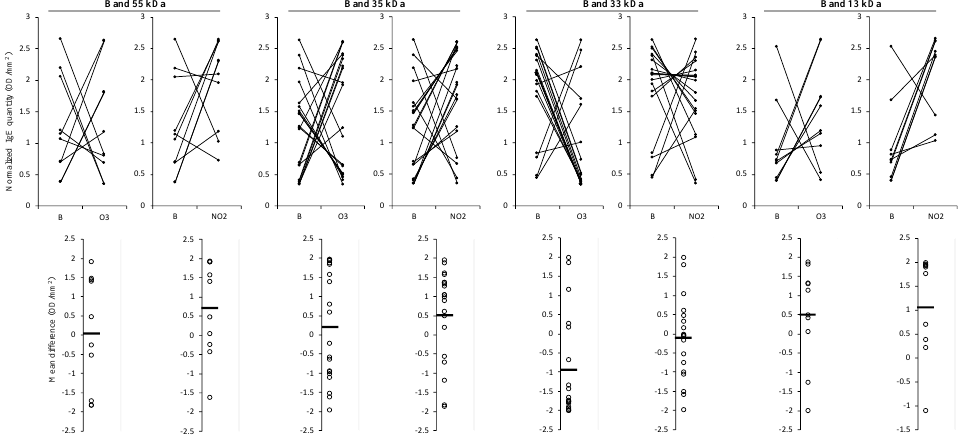
Figure 6. Results of the variation of total IgE binding normalised volume (OD/mm 2 ) in the 1D Western blot observed between non-exposed pollen (B) and exposed to pollutants (O 3 or NO 2 ) for the four most common reactive bands (55, 35, 33, and 13 kDa) in the 21 patient sera tested. Below each graph is presented the respective mean differences in IgE reactivity (expressed in OD/mm 2 ). The IgE responses of patients were normalised based on the content of electrophoretic profiles of non-exposed, O 3, and NO 2 exposed pollen samples, using the z-scores method. The differences were expressed in OD/mm 2 , calculated based on each volume profile and total area.